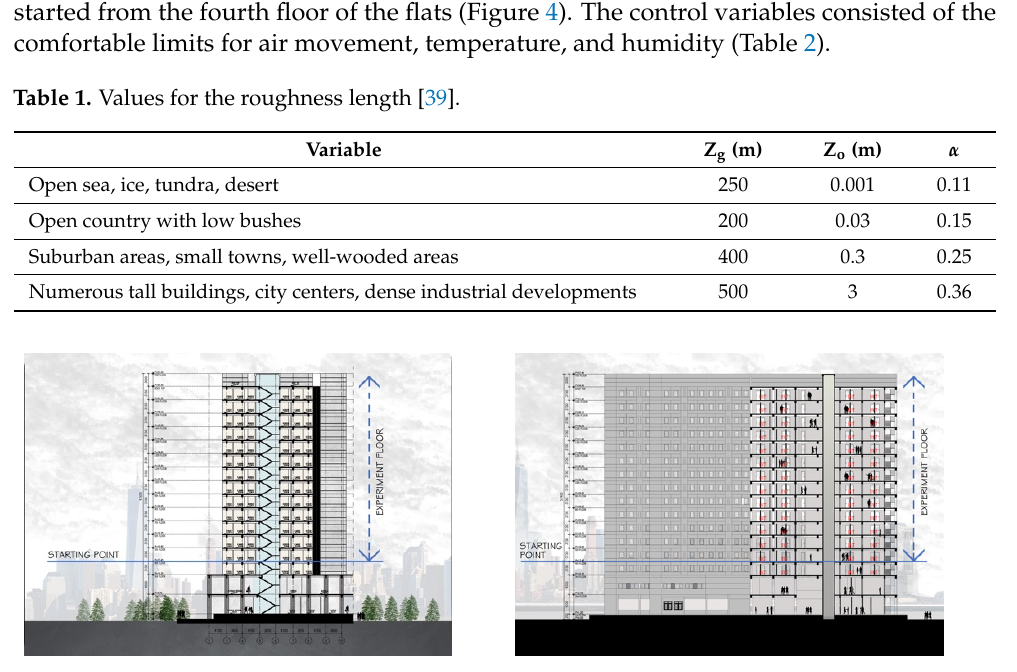
Figure 3. Wind rose data for the last 3 years.